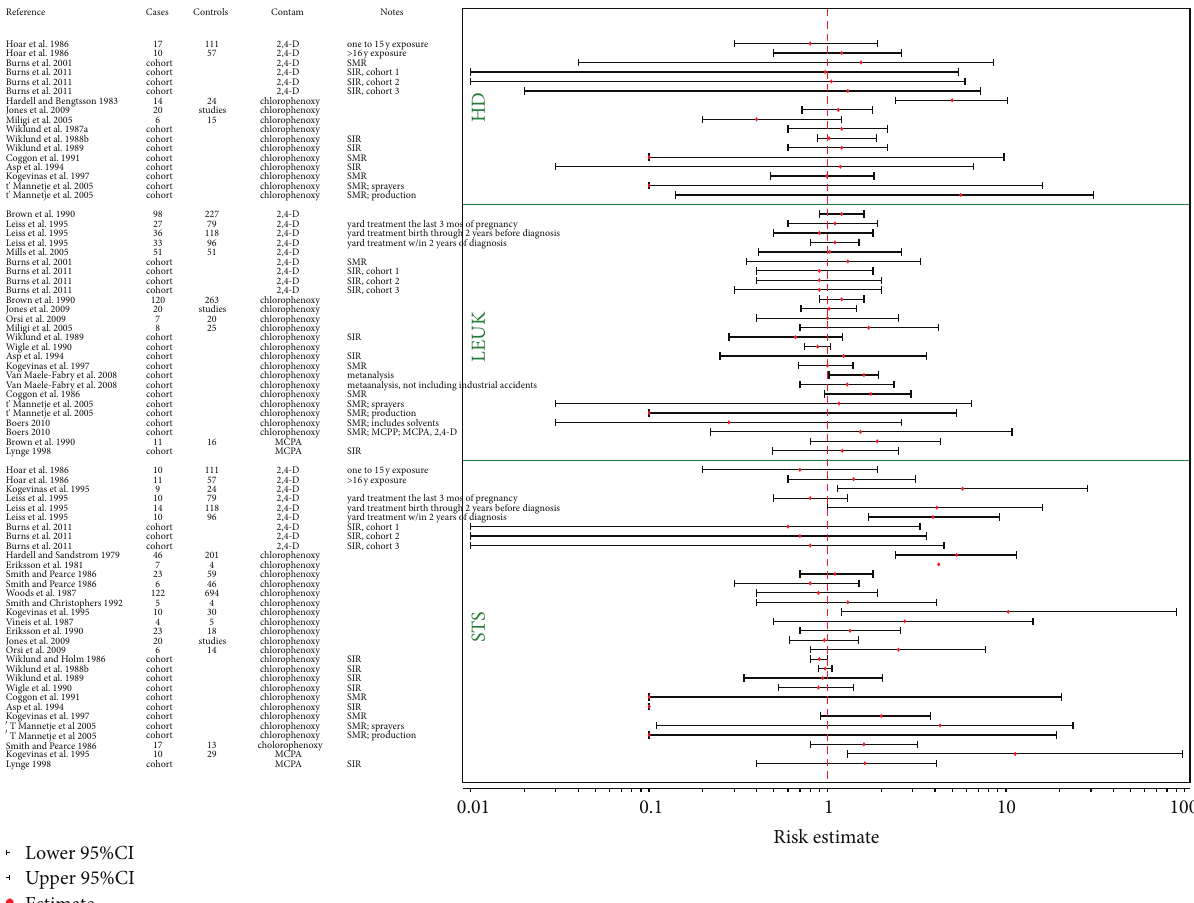
Figure 4: Summary of epidemiologic studies for STS, HD, and leukemia (see for review [12, 44, 57, 59, 66, 70, 75–80, 80–87, 89–99]).